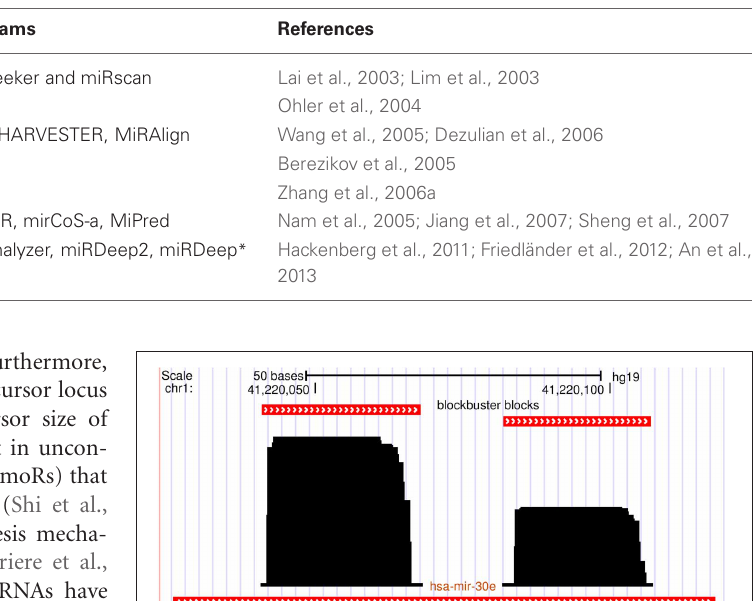
Table 1 | Major approaches for the computational prediction of micro-RNA.